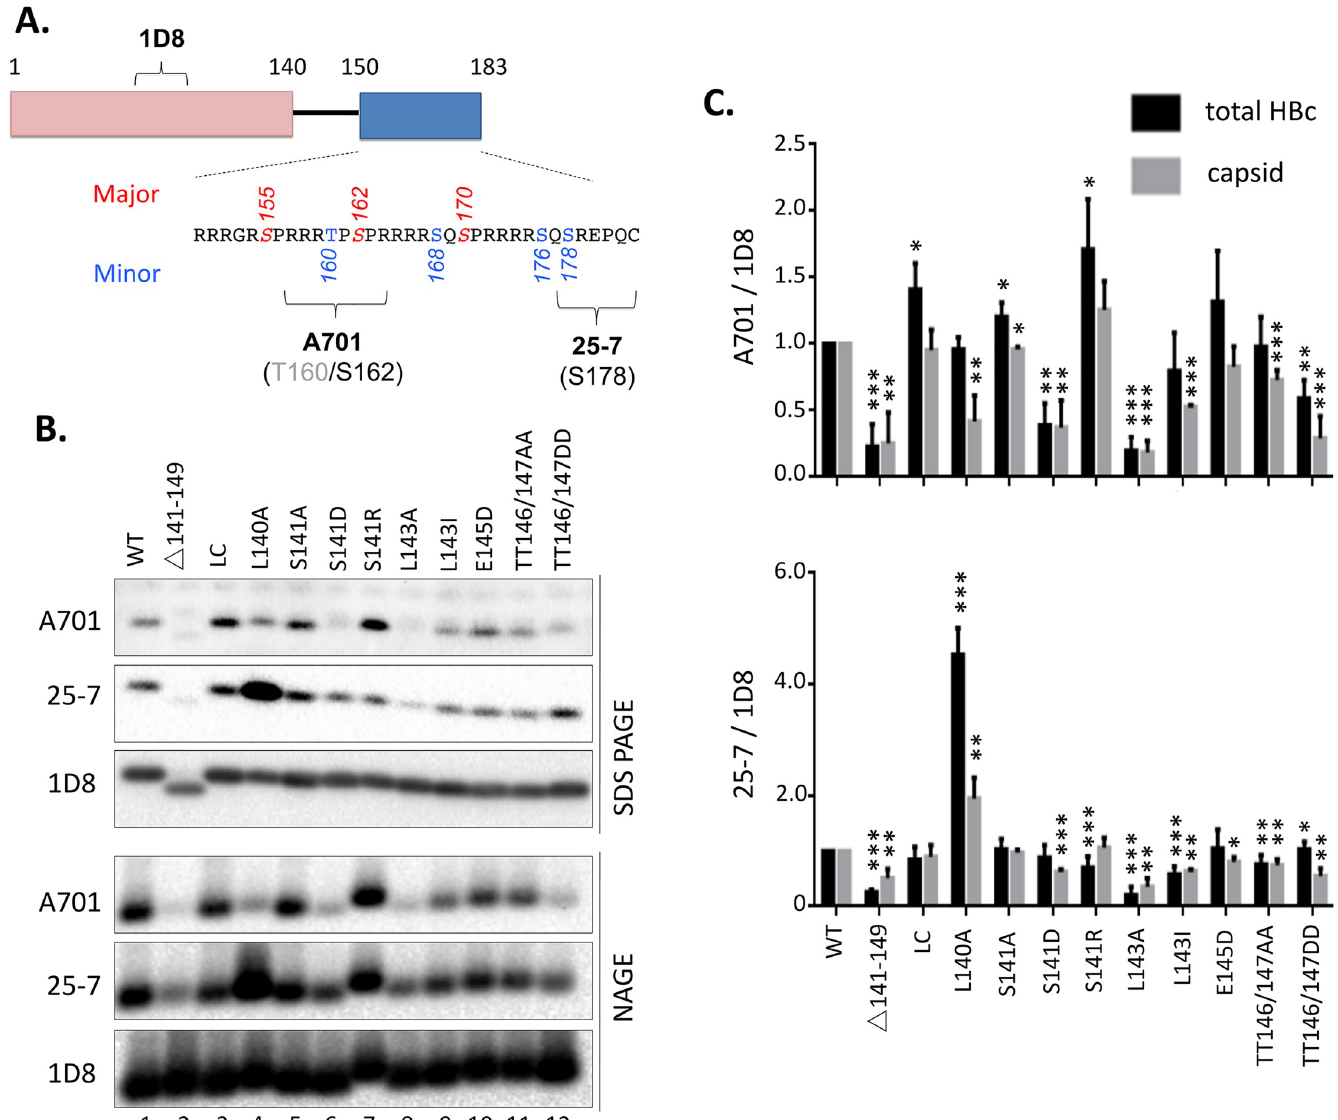
Fig 2. Effects of HBc linker mutations on CTD state of phosphorylation. A. Schematic of HBc domain structure and mAb epitope locations. The NTD and CTD are depicted as pink and blue boxes, with the linker peptide in between as a thin line. Epitopes recognized by the HBc-specific mAbs: 1D8 for NTD (ca. 70–80), independent of CTD state of phosphorylation; A701 for unphosphorylated S162/T160; and 25–7 for unphosphorylated S178. B. HepG2 cells were transfected with indicated HBc expression constructs and were harvested seven days post-transfection. Cytoplasmic lysates from the transfected cells were resolved by SDS-PAGE (top) or NAGE (bottom) and detected by western blot analysis, using the NTD-specific mAb 1D8 (for total HBc proteins) and two non-phosphorylated CTD-specific mAbs, A701 and 25–7. C. The CTD dephosphorylation signals from total HBc (quantified following SDS-PAGE; black bars) or capsids (quantified following NAGE; gray bars) were normalized to total HBc or capsid signal (A701/1D8, top; 25-7/1D8, bottom). The normalized A701 or 25–7 signals of the linker mutants are shown relative to that of the WT HBc, which was set to 1.00. � , P < 0.05; �� , P < 0.01; ��� , P <